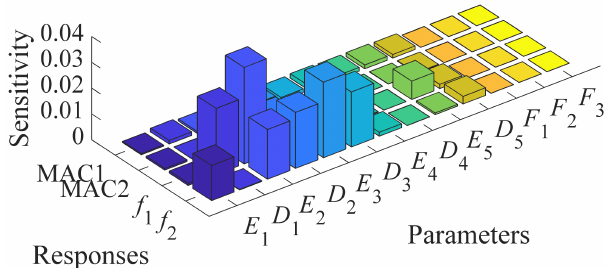
Figure 12. Updating parameter